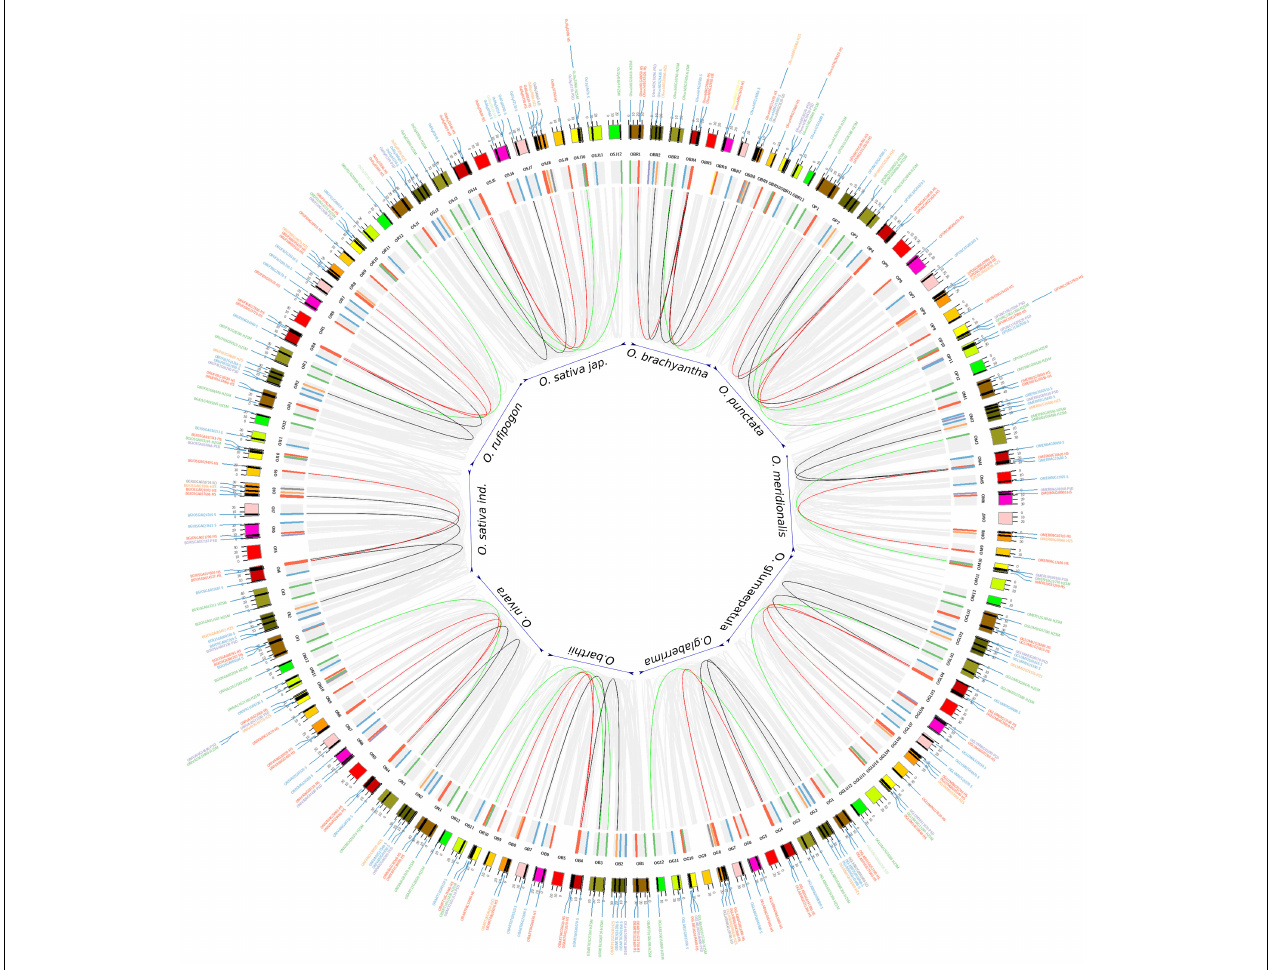
FIGURE 4 | Self-collinear blocks of 10 Oryza species. Outer circle: 12 chromosomes from each of the 10 Oryza genomes that are represented in default colors of circos. Inner circle: START genes are shown as colored bar highlights. Color codes for bar highlights and labels are same as Figures 2 , 3 . Connectors (internal to the bar highlights) are formed between the START homologs that occur as collinear blocks on different chromosomes of the same genome and follows same color codes of START types except for START homologs that belongs to two different structural classes are linked with a black line. Gray connectors are used for showing non-START homologs within the genomes of 10